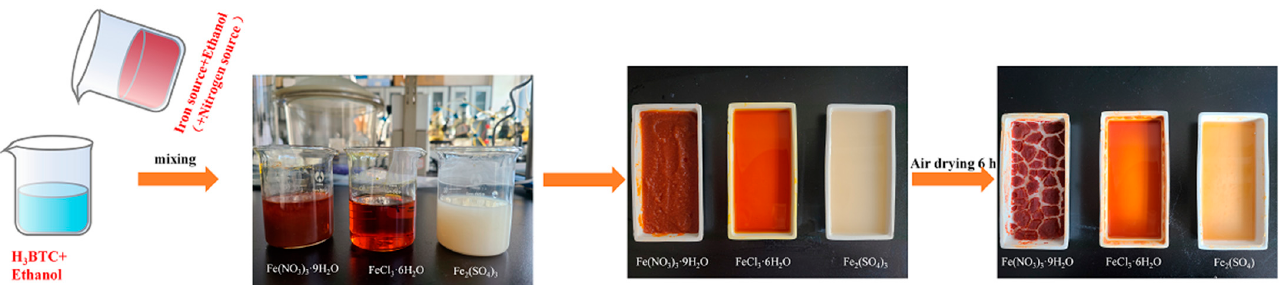
Figure 2. Fe-BTC diagram prepared by different metal salts.